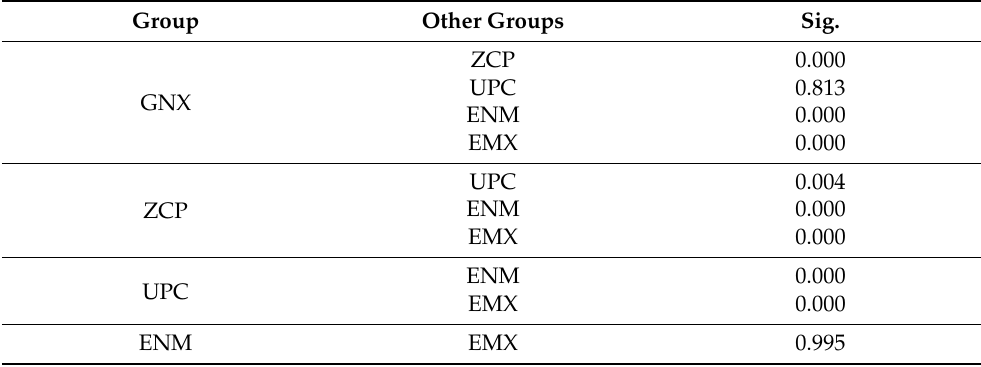
Table 11. Multiple comparisons between OP values for the non-aged groups. Shaded cells indicate significant differences p <